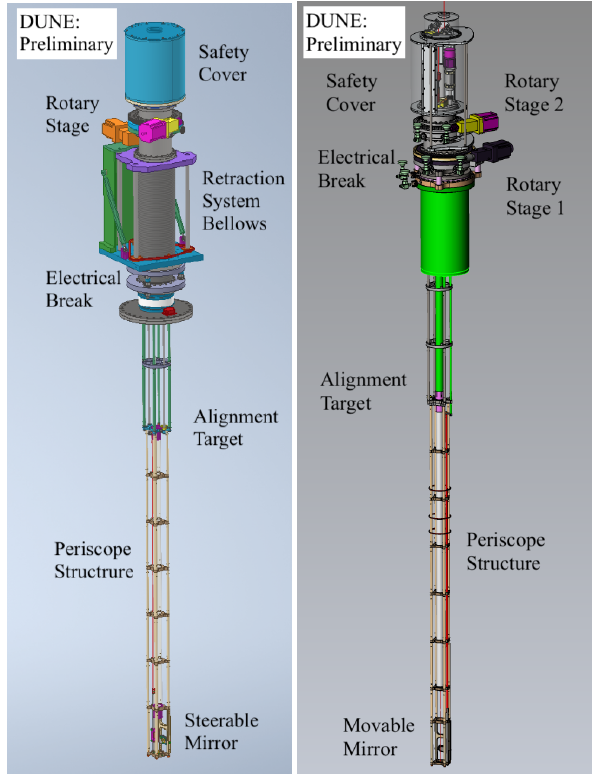
Figure 7. Schematics of the two periscope designs for DUNE laser calibrations: ( left ) Periscope 1, for penetration into the top (horizontal) TPC field cage, includes a retraction mechanism. ( right ) Periscope 2, for deployment next to the lateral (vertical) field cage, provides two eccentric rotation movements, to minimize shadowing